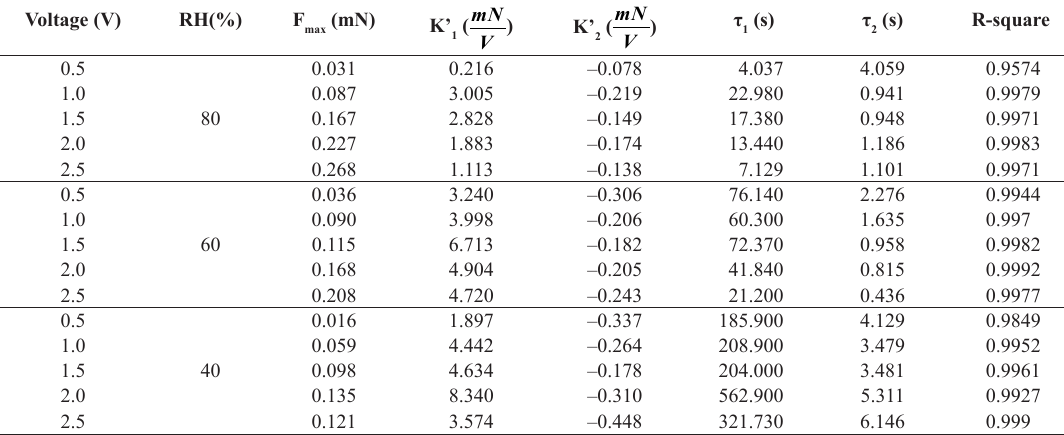
Figure 2. Experimental setup: chamber with RH controller equipped with a load cell and electrical terminals. Table 1. Experimental parameters extracted from a N117 based IPMC with Na +